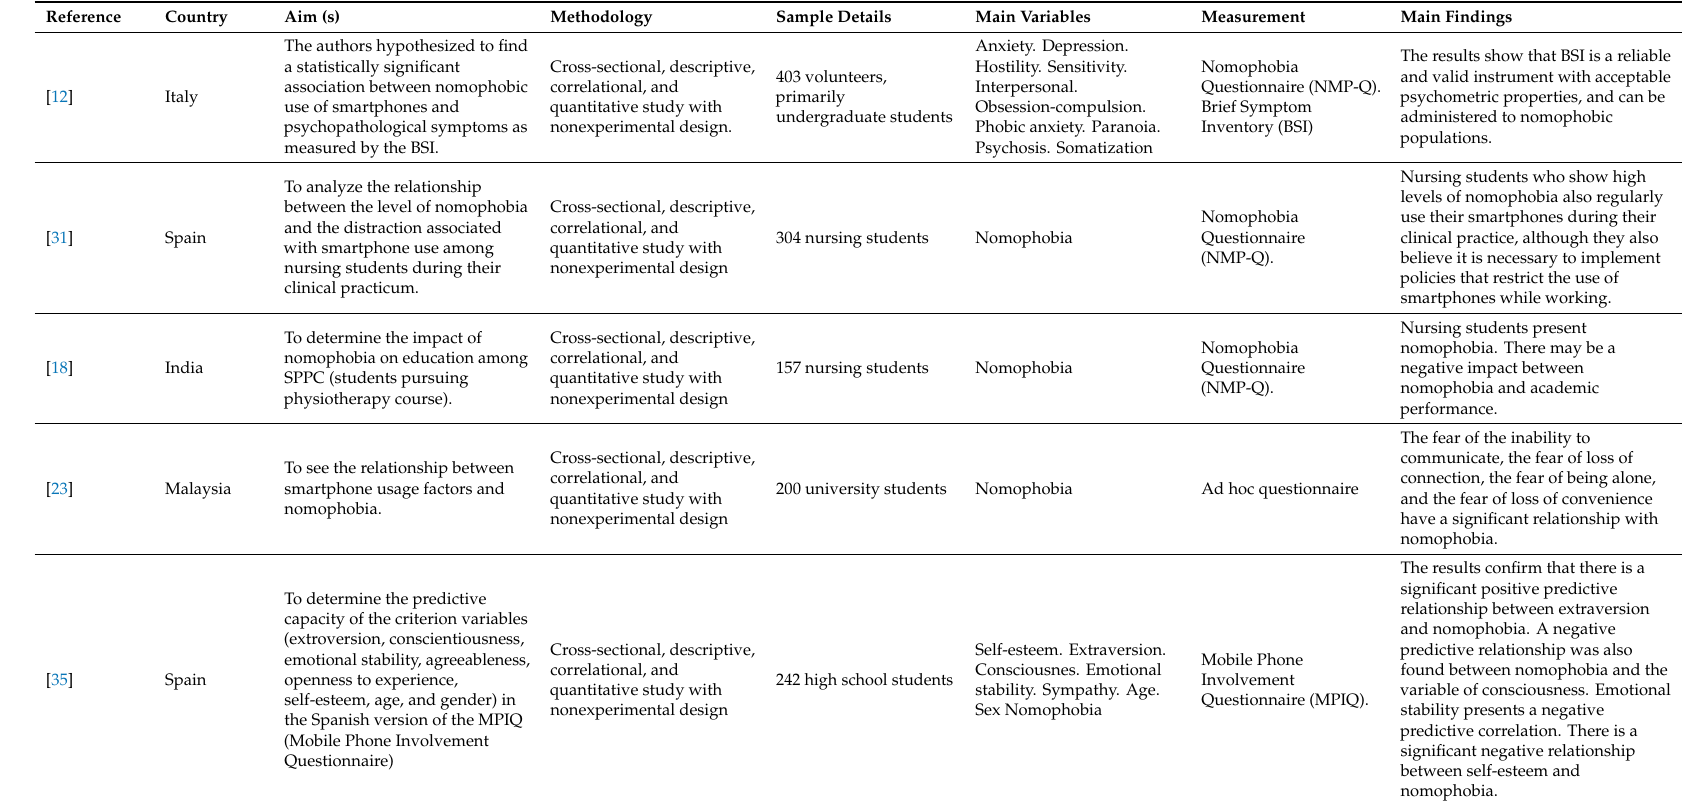
Table A1. Experimental or nonexperimental